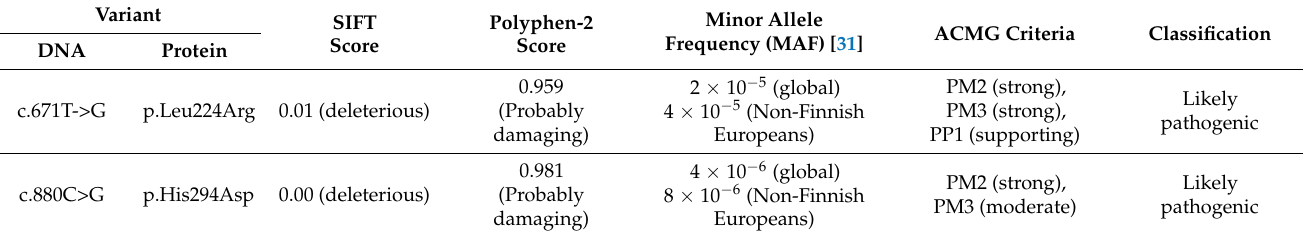
Table 2. Assessment of pathogenicity of the novel missense variants in PJVK